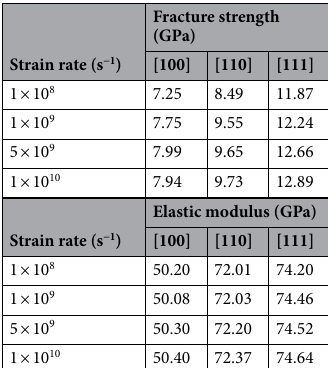
Strain rate (s −1 )